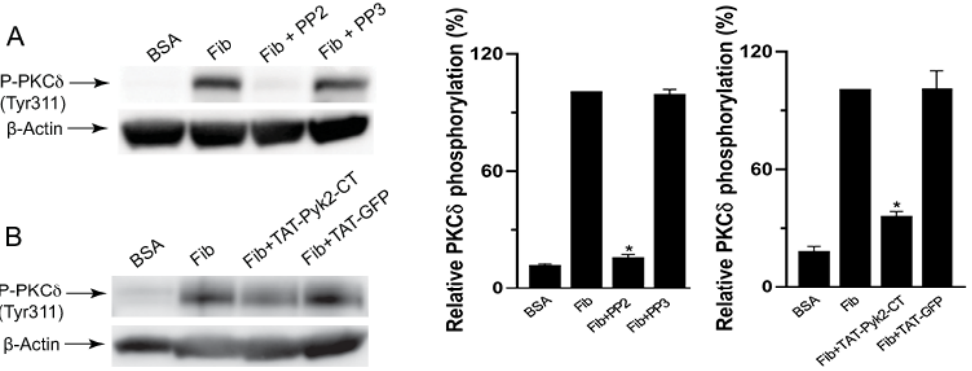
Figure 2. The effect of Src and Pyk2 inhibition on αIIbβ3-mediated PKCδ phosphorylation. ( A ) Fibrinogen-adherent platelets in the presence of 10 µM PP2 or 10 µM PP3 were probed with anti-phospho-PKCδ (Tyr311) or anti-β-actin antibodies. The blots shown are representative of three independent experiments and are presented as mean ± SE. * p < 0.05. ( B ) Fibrinogen-adherent platelets in the presence of Pyk2 inhibitor TAT-Pyk2-CT or TAT-GFP (control) were probed with anti-phospho-PKCδ (Tyr311) or anti-β-actin antibodies by Western blotting. The blots shown are representative of three independent experiments and are presented as mean ± SE. * p < 0.05.